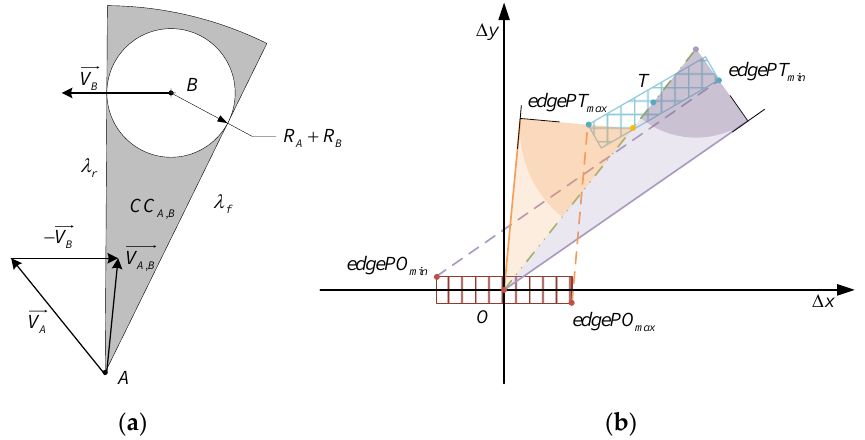
Figure 1. Schematic of the velocity obstacle. ( a ) Velocity obstacle for robots, ( b ) velocity obstacle for inland ships.